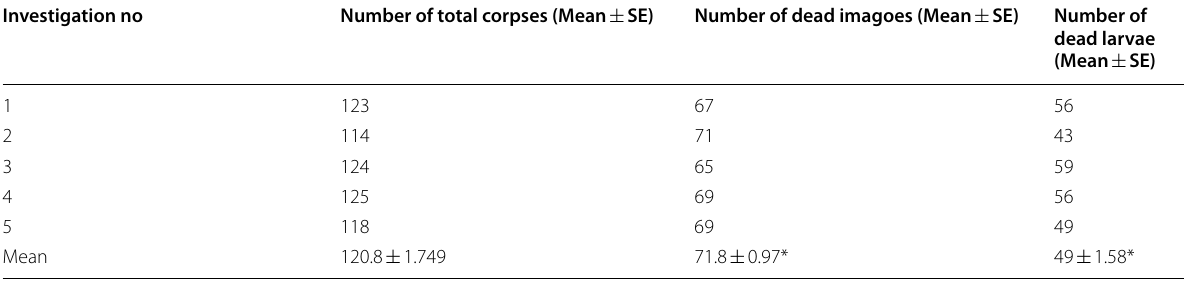
Table 3 Infection effect of the fungal entomopathogen on the growth stages